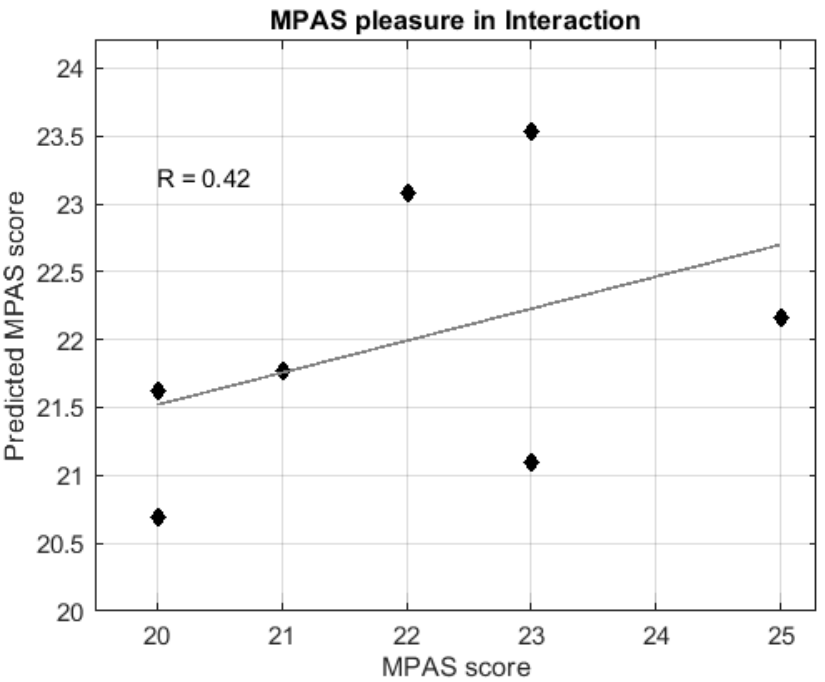
Figure 4. Regression analysis of the postpartum MPAS subscale of “Pleasure in Interaction” based on the gray matter volume changes between pre-pregnancy and six years after parturition sessions. The graph shows predicted (X-axis) versus actual “Pleasure in Interaction” MPAS score (Y-axis). The mean value (±s.d.) of the predicted score is 22.127 (±1.140), the correlation coefficient with the actual score is (R) = 0.65, p -value = 0.020, nMSE = 0.330, and pnMSE = 0.017. Abbreviations are as follows: MPAS = maternal postpartum attachment scale, s.d. = standard deviation, nMSE = normalized mean squared error, pnMSE = p -value of normalized mean squared error.